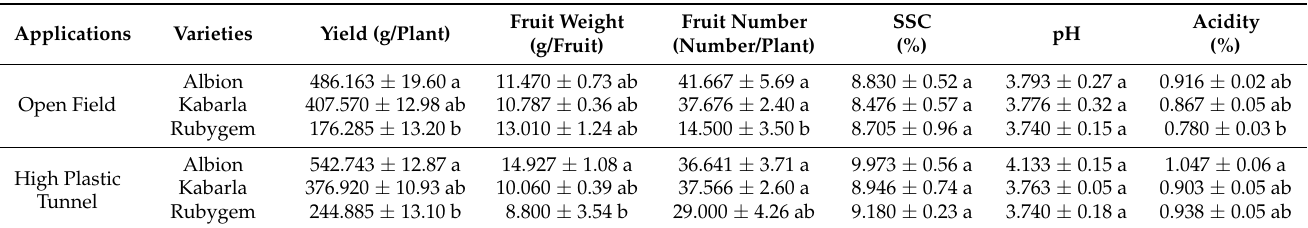
Table 1. Fruit properties of strawberry cultivars grown in open field and high plastic